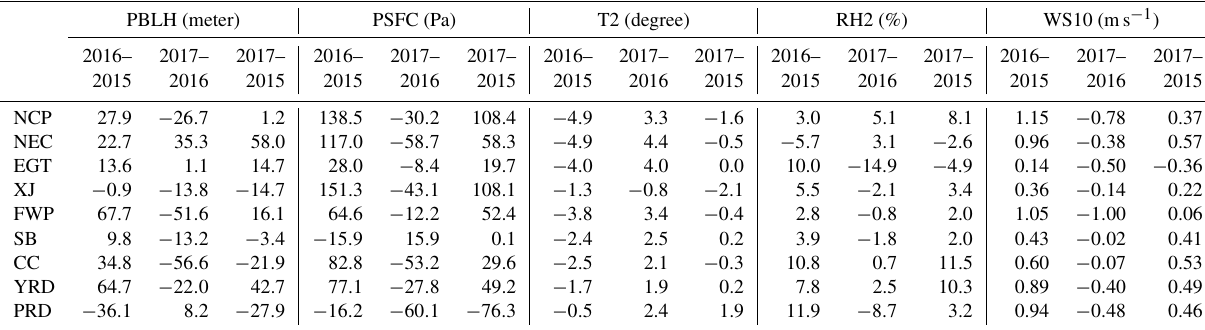
Table 5. Statistics of the meteorological differences by region for January 2015, 2016 and